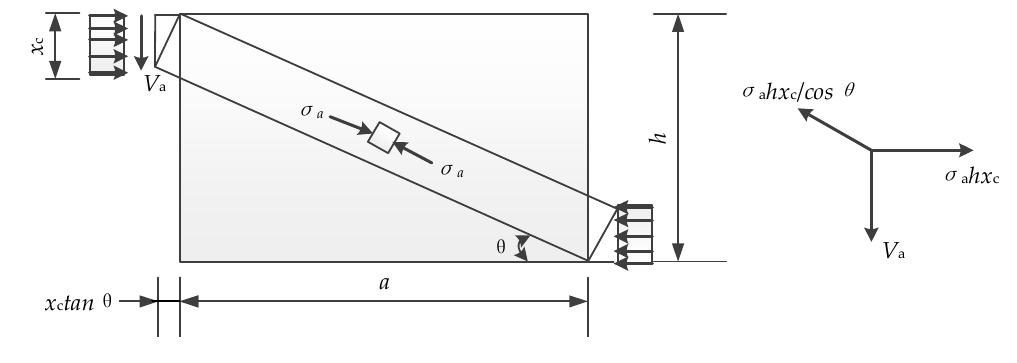
Figure 11. Compressive zone for Arch model.